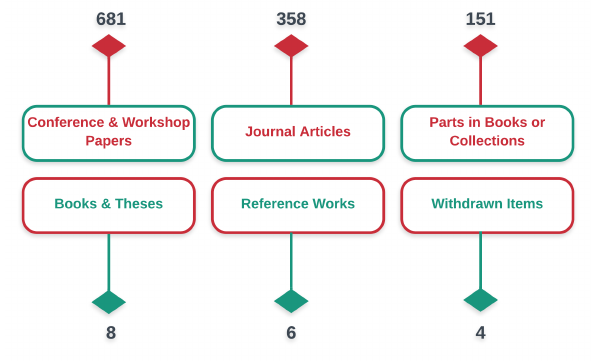
Figure 3. Types of research items on the topic of Link